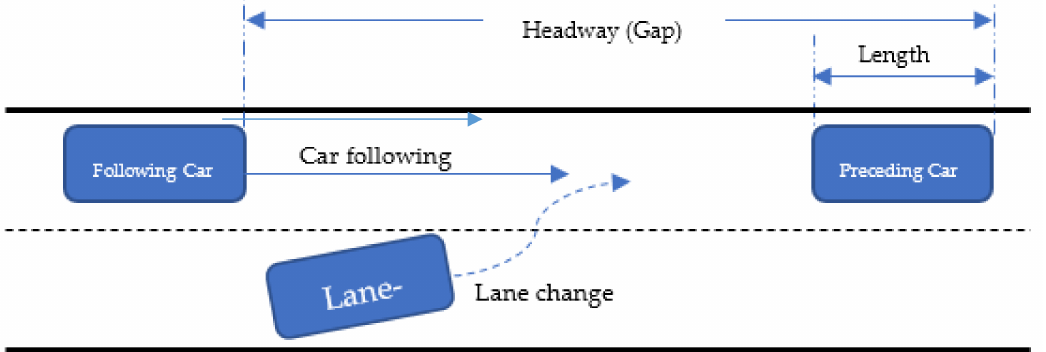
Figure 1. Typical illustration for car-following, lane-change, and gap-acceptance.